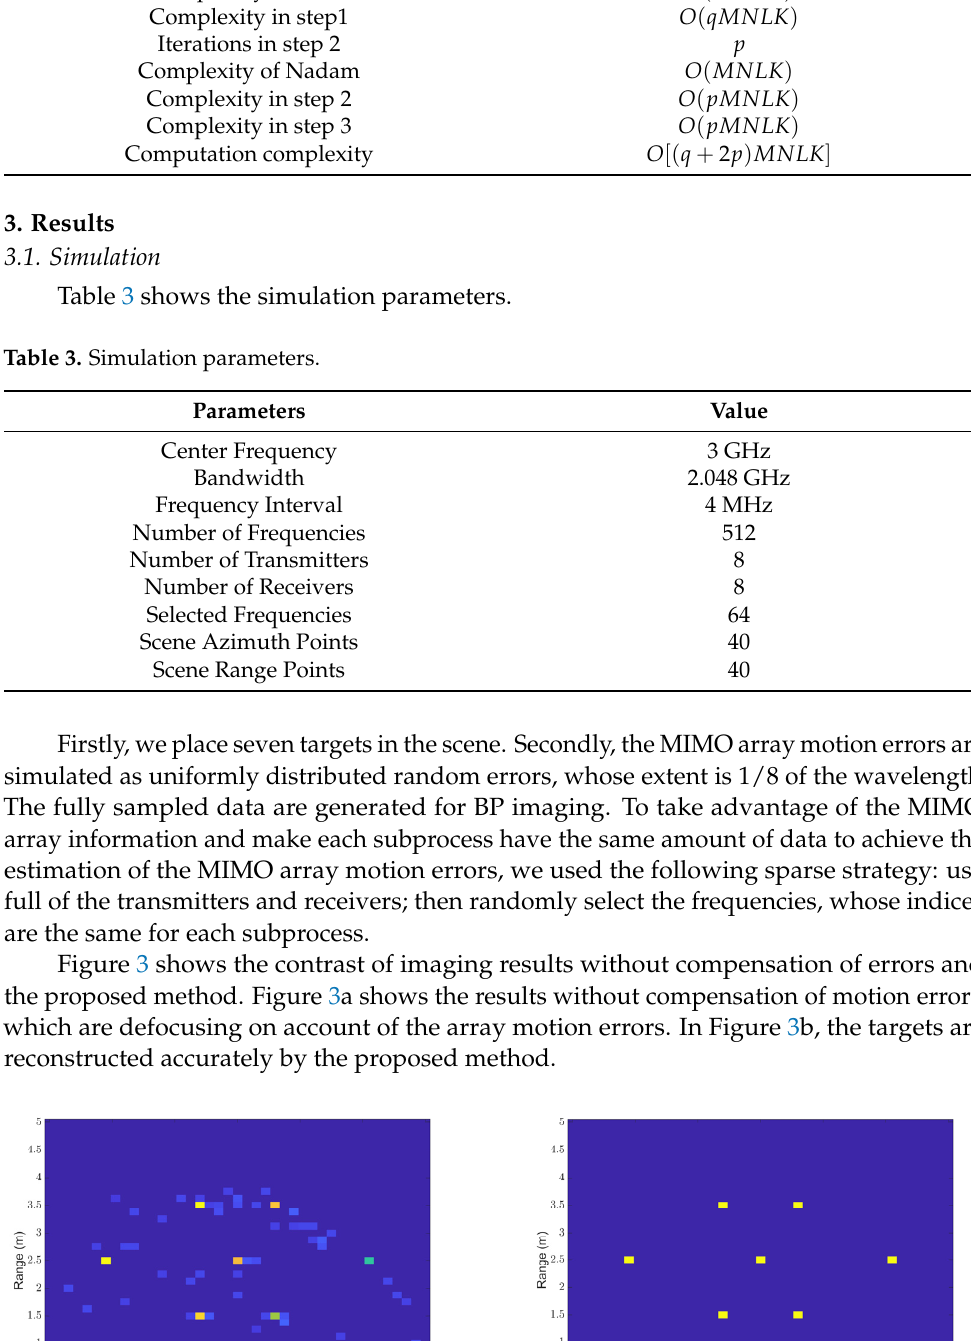
elements, where the horizontal coordinate represents the serial number of the transm − itting array. Figure 4d also shows the comparison between the error estimation result and the true error value of the x dimension of the 8 receiving array elements, where the horizontal coordinate represents the serial number of the receiving array. Com- bined with Figure 4a,d the error estimation accuracy of the x dimension of the transmitting and receiving array is given. The remaining two columns depict the estimation precision in the y and z dimension, respectively. The results show that the estimation of errors of this method is in good agreement with the real errors.